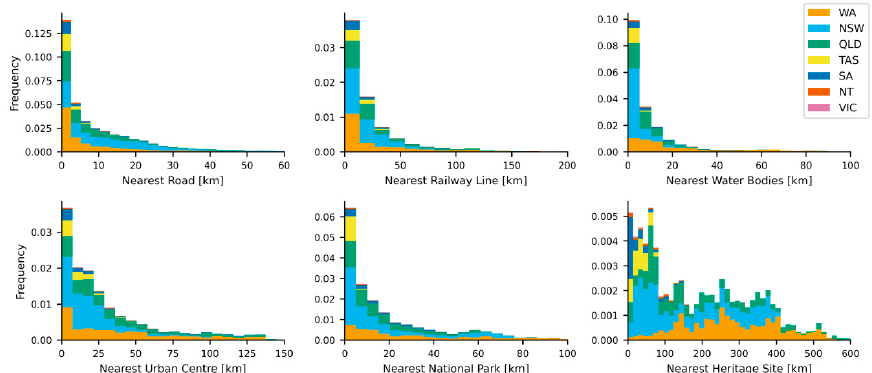
Figure 5. State-by-state breakdown of abandoned mines located within 1 km of urban areas, national parks, national heritage and Indigenous heritage areas. Figure 6. Frequency distribution of abandoned mine proximity to major transport routes, waterways and lakes, urban centres, national parks and heritage sites. Stacked plots show both national and state-level proportions, distance value limit on the x -axis encompasses up to 90% of mine features.